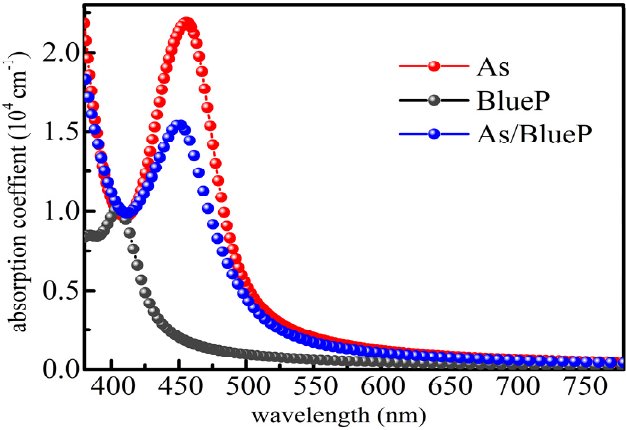
Figure 4. Optical absorption coefficient in the visible light region of monolayer As, monolayer BlueP, and the As/BlueP hetero-structure.